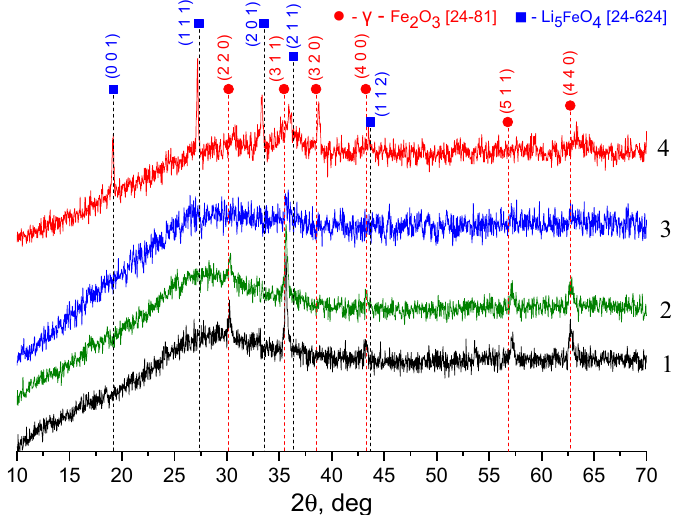
Figure 2. X-ray diffraction images (XRD) patterns of KFS glass samples: 1—tempered glass; 2— annealed glass; 3—glass after the ion exchange treatment in NaNO 3 melt at 450 ° С for 9 h;